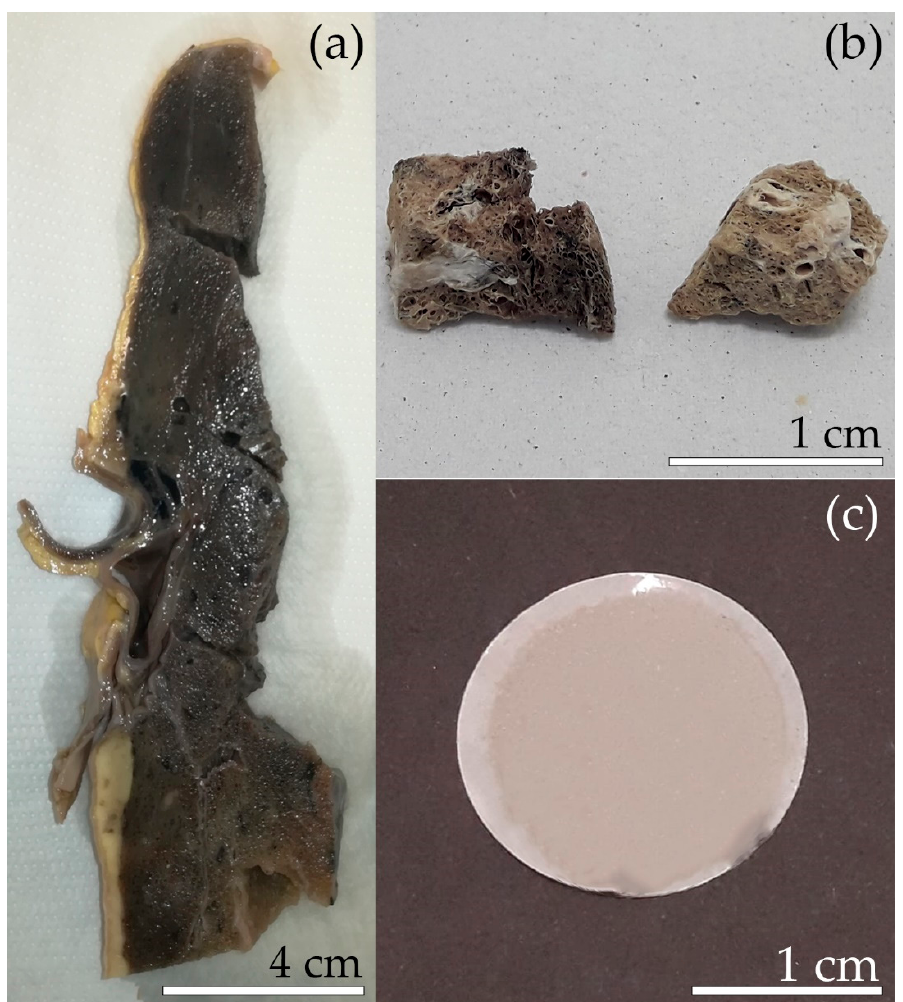
Figure 1. Lung tissue before and after dissolution; ( a ) parenchyma stored in a formaldehyde solution; ( b ) lung tissue sub-samples after lyophilisation; ( c ) filters recovered after low-temperature plasma asher procedure.